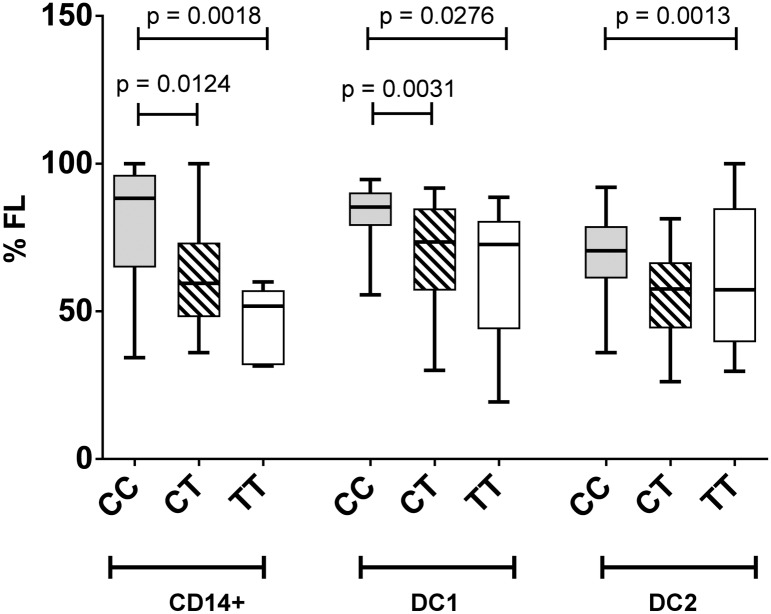
Lower proportions of the full-length isoform expressed from the CD40 risk allele in monocytes and dendritic cells.Association of rs1883832 genotype (CC, TC, TT) with the proportion of full-length isoform of CD40 (%FL) expressed in in vitro differentiated dendritic cells (DC1, DC2) from healthy controls (n = 49). Molar ratios of isoforms were quantitated by RT-PCR and amplification of a region spanning CD40 exon 4–10, followed by electrophoretic separation and fluorescent detection (Bioanalyzer, Agilent); p values by Mann-Whitney test.